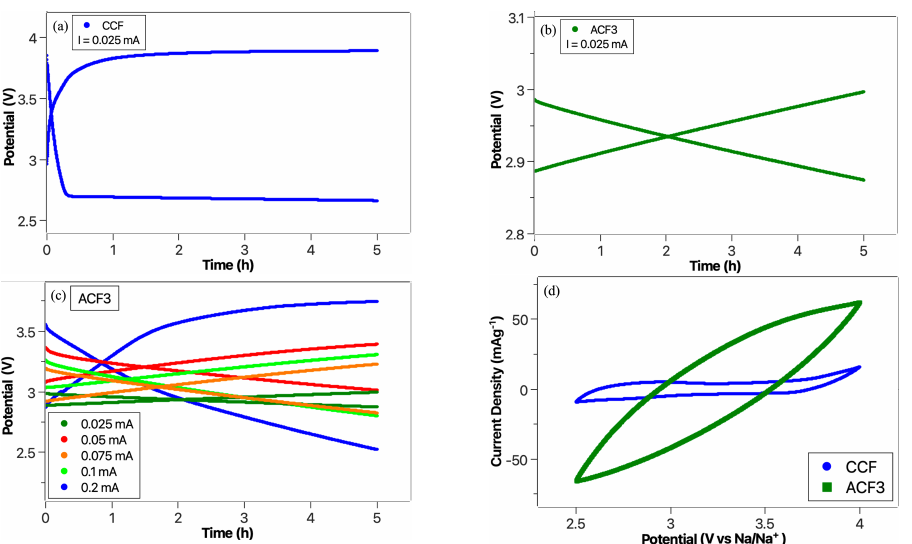
Figure 5. Galvanostic charge–discharge cycles of a SWB cell with ( a ) CCF and ( b ) ACF3, at a current of 0.025 mA, ( c ) charge–discharge profiles of a SWB cell with ACF3 at different currents with a 5 h duration, in a two electrode connection, and ( d ) cyclic voltammetries of a SWB cell with CCF and